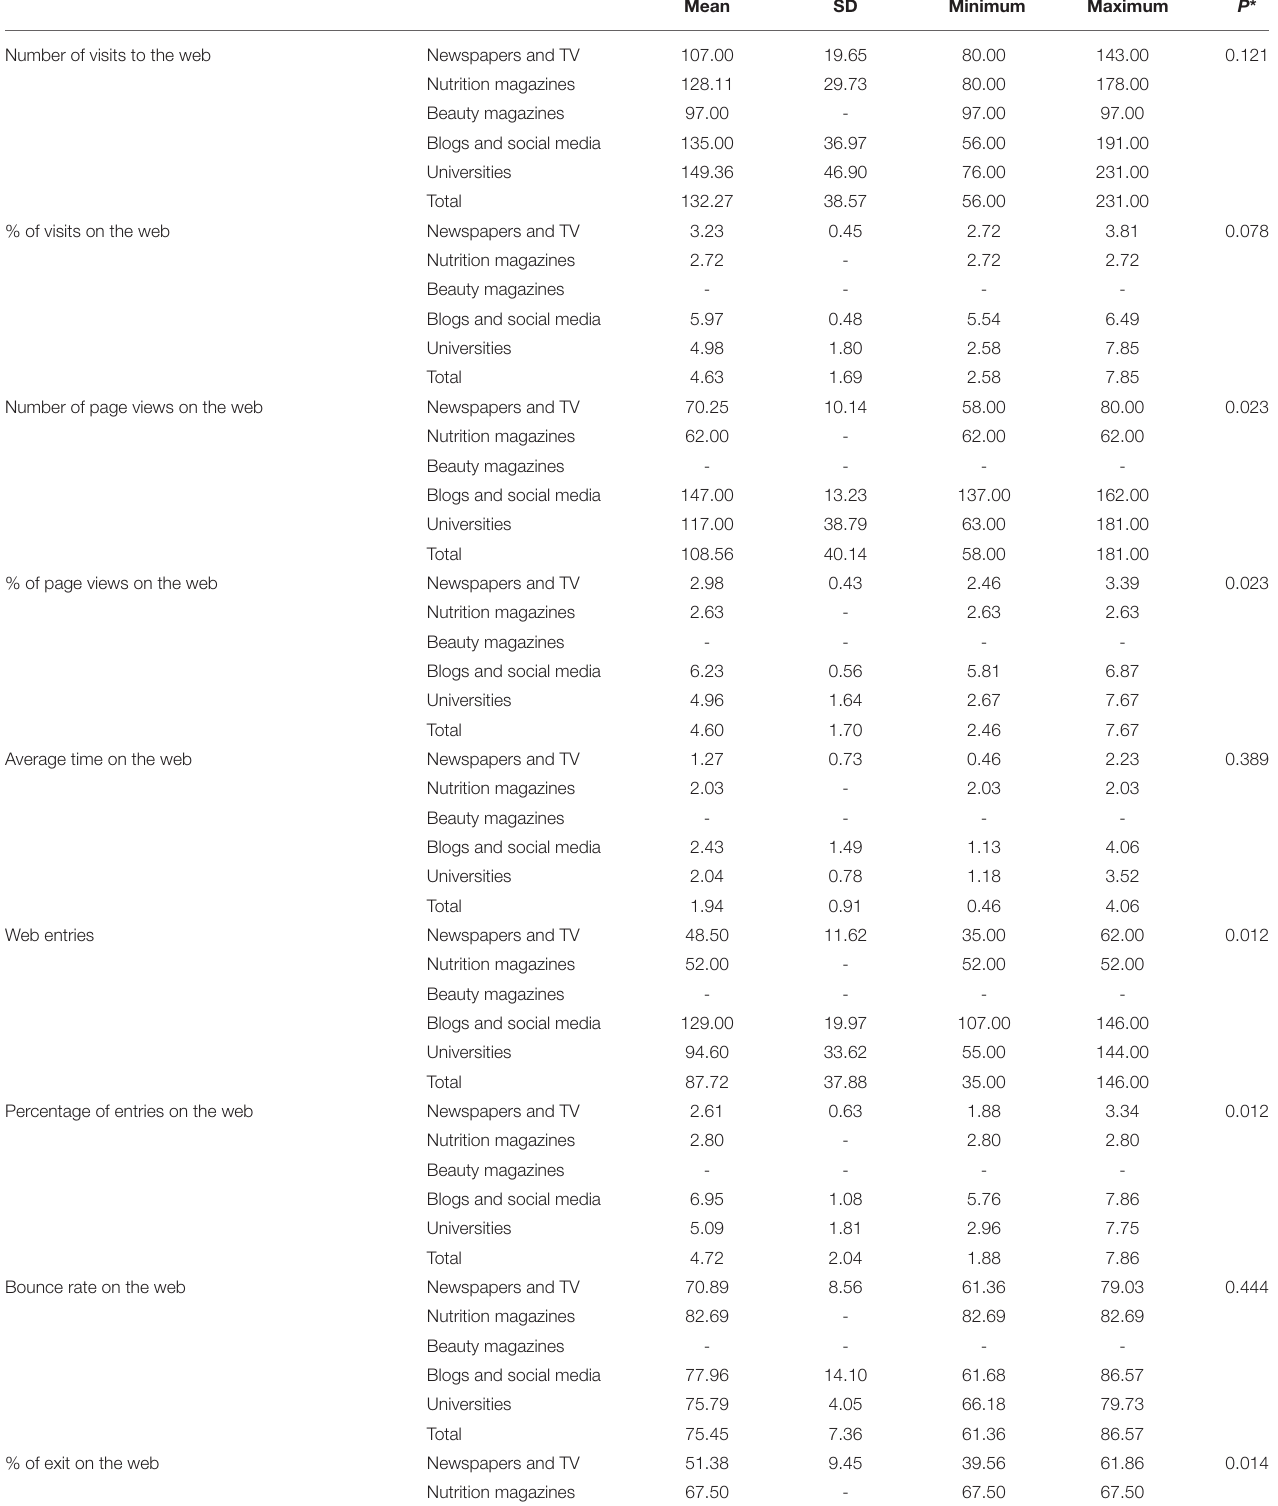
TABLE 2 | Comparison of the mean values measured on the websites according to the communication medium. Mean SD Minimum Maximum P